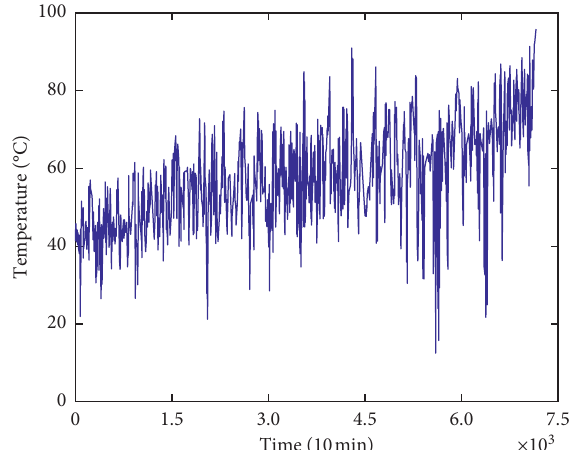
Figure 9: Temperature monitoring data of the HSS bearing.